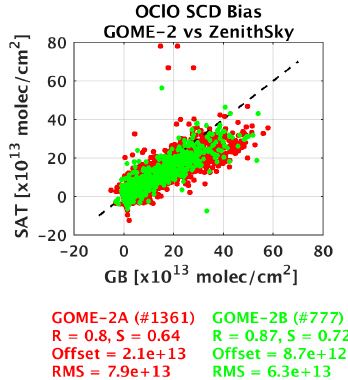
Figure 17. Scatter plot between daily GOME-2A (red) and GOME- 2B (green) GDP 4.8 satellite data and ground-based data for all the stations included in the study during the active